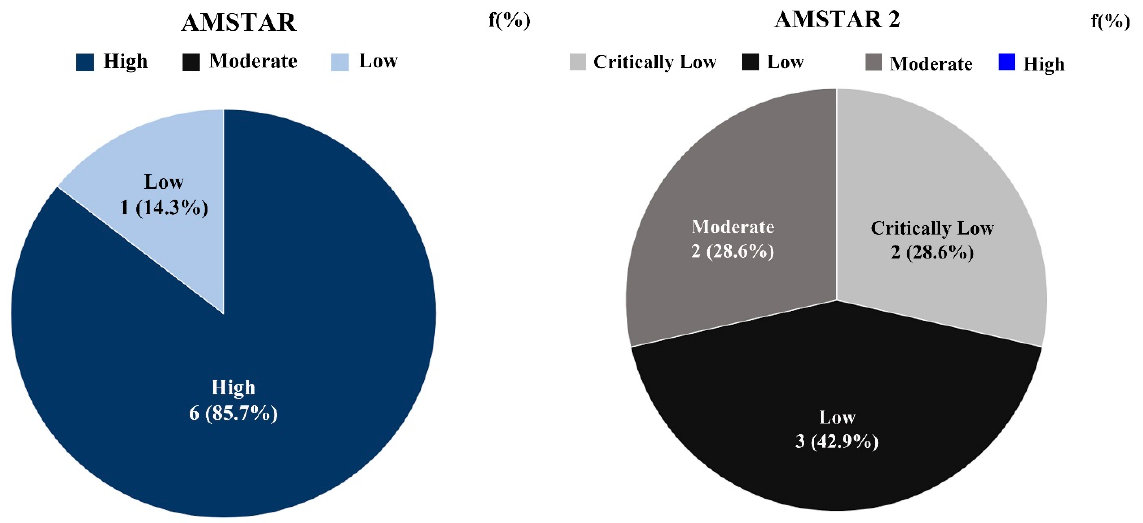
Figure 3. Quality evaluation according to the assessment tool of meta-analysis research related to dance therapy.